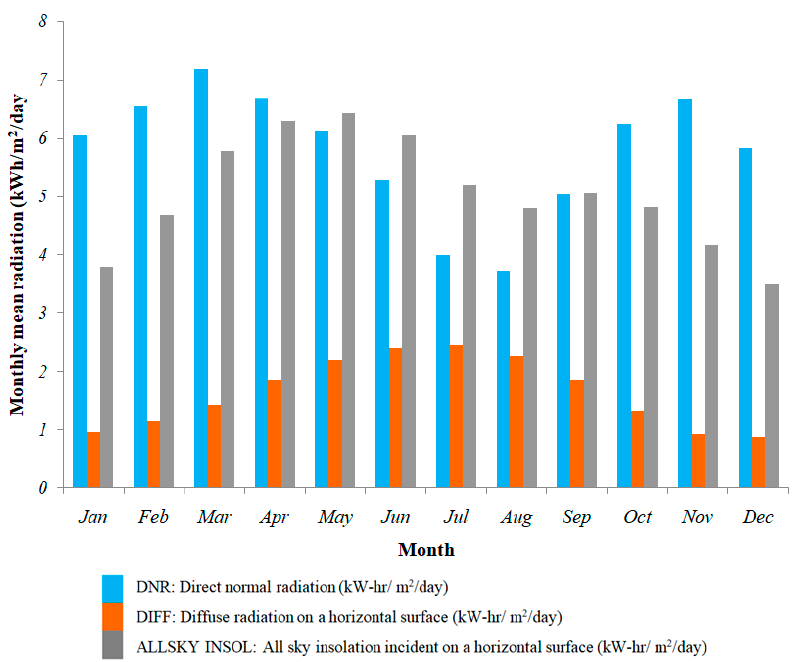
Figure 8. ALLSKY INSOL, DIFF and DNR of the solar radiation of theselected location.